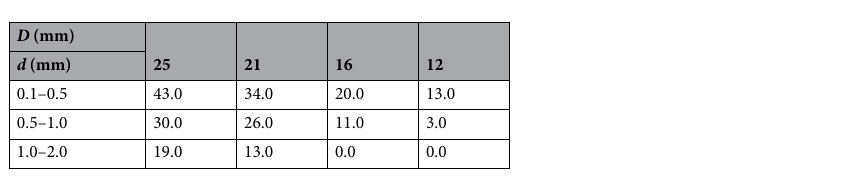
Table 1. Speed of sand flow v (mm/s) with different diameters of sand and